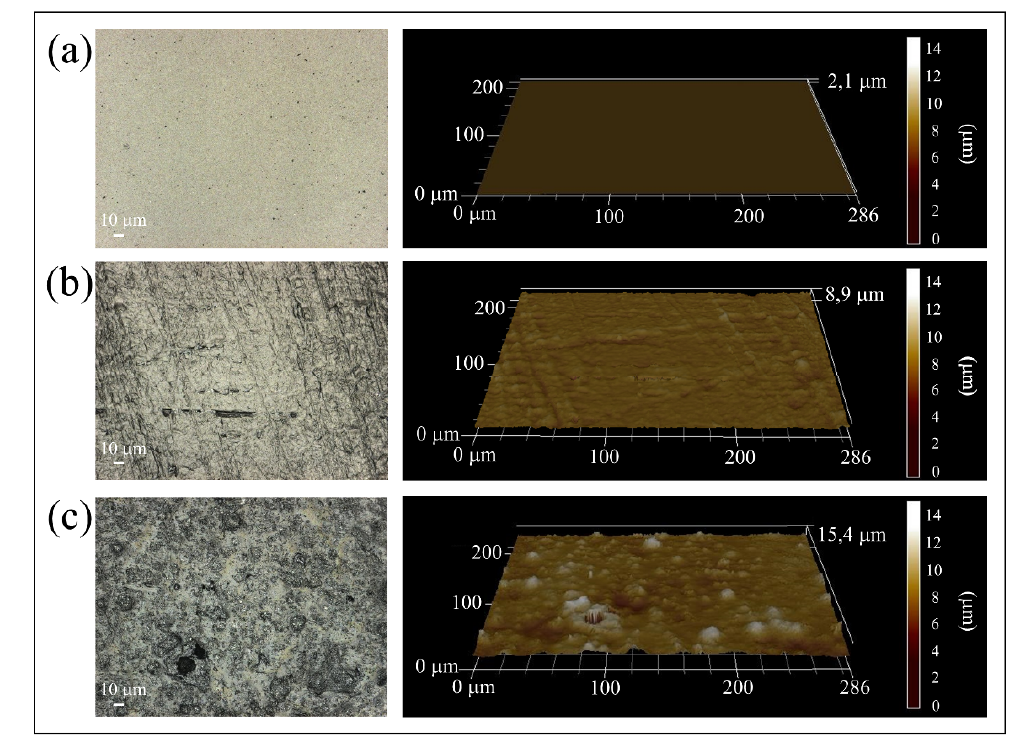
Figure 1. Laser microscopy images (left side) and relative topographic data (right side) of ( a ) bulk silicon nitride, ( b ) untreated polyethylene matrix and ( c ) polyethylene matrix combined with Si 3 N 4 powders.